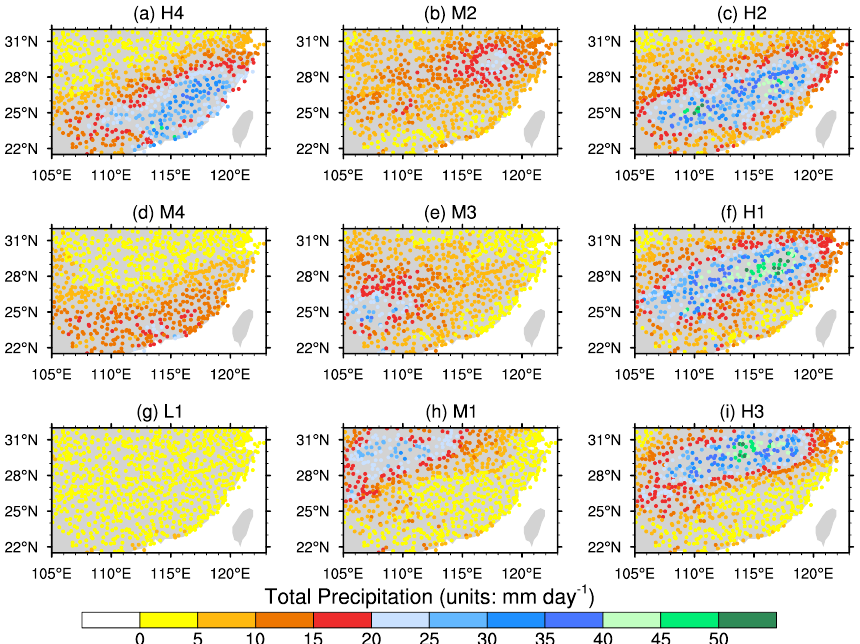
Figure 15. ( a – i ) Composite means of precipitation (units: mmday − 1 ) for the nine regimes during AMJ 1979–2014 based on precipitation data from surface stations. Note that the end year of the available precipitation data from the surface stations is 2014. Thus, we only composite precipitation regimes during 1979–2014.